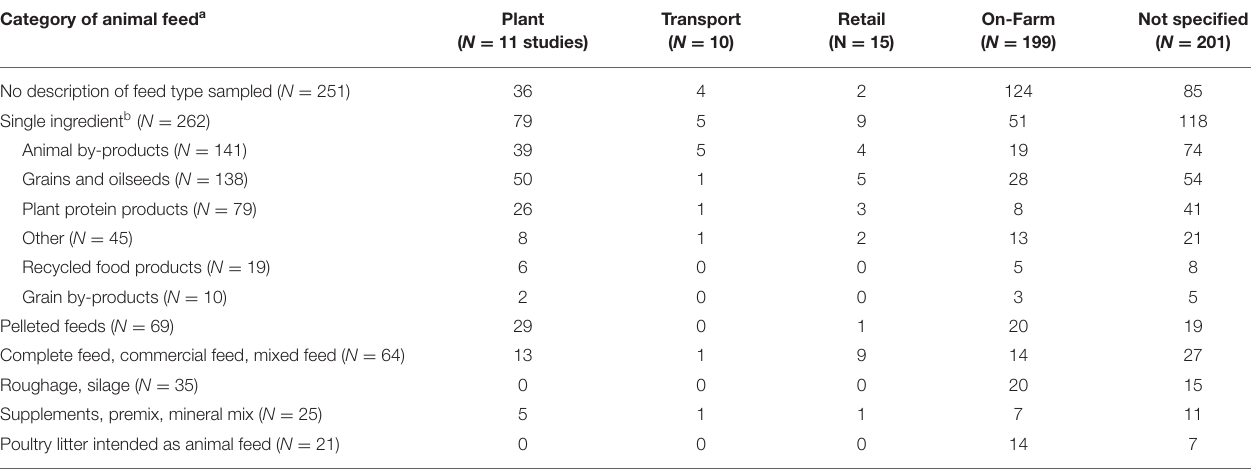
TABLE 3 | Types of animal feeds sampled to investigate Salmonella across sectors of animal feed production from 537 studies. Category of animal feed a